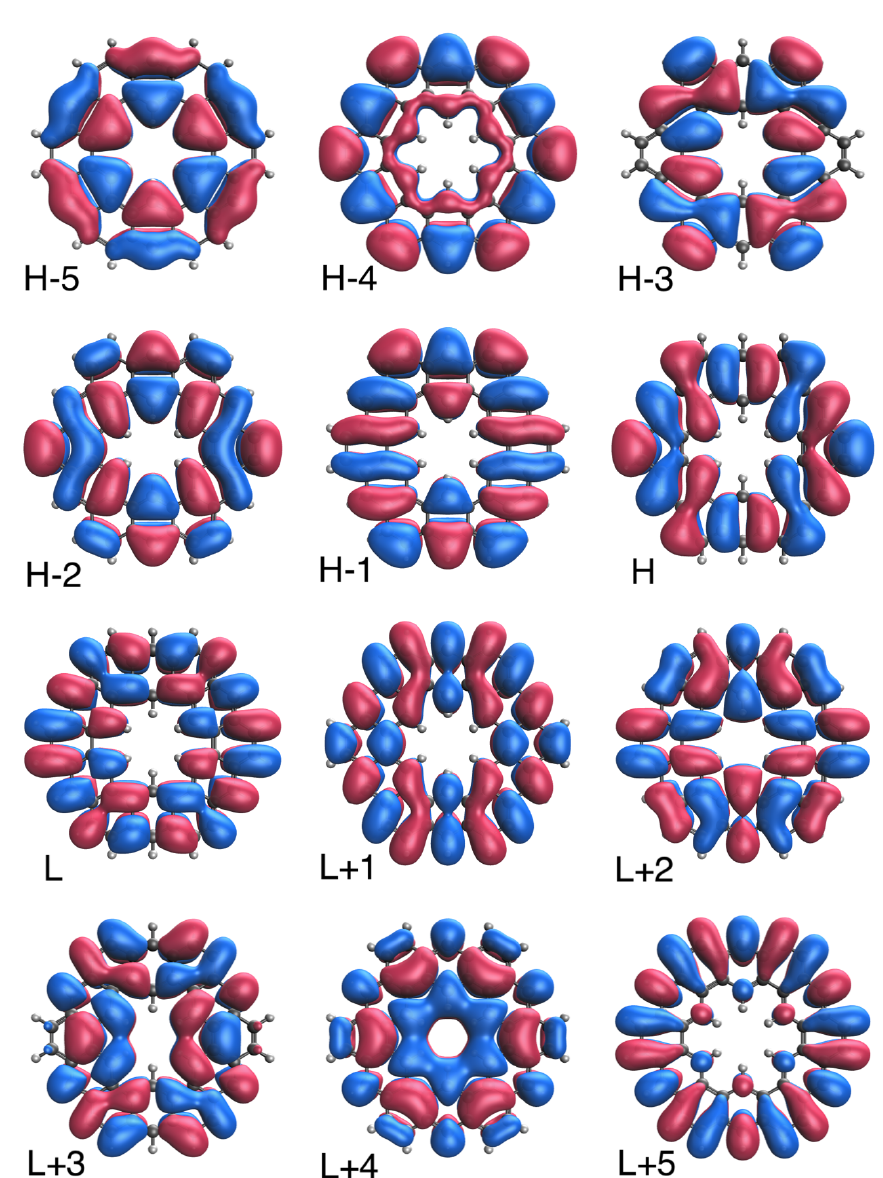
Figure 6. Real-space representation of active TAO-orbitals, such as H − 5 (2.000), H − 4 (2.000), H − 3 (1.998), H − 2 (1.998), H − 1 (1.996), H (1.996), L (0.003), L + 1 (0.003), L + 2 (0.002), L + 3 (0.002), L + 4 (0.000), and L + 5 (0.000), of ground-state 3-HGQR, obtained from spin-restricted TAO-LDA, at isovalue = 0.02 e/Å 3 . The TOONs are given in